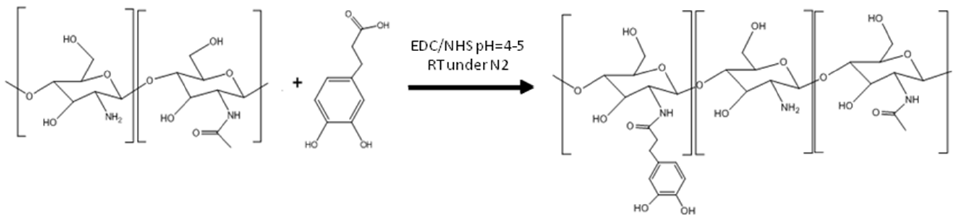
Figure 5. CHI-CA synthesis reaction at pH = 4–5 at room temperature under nitrogen